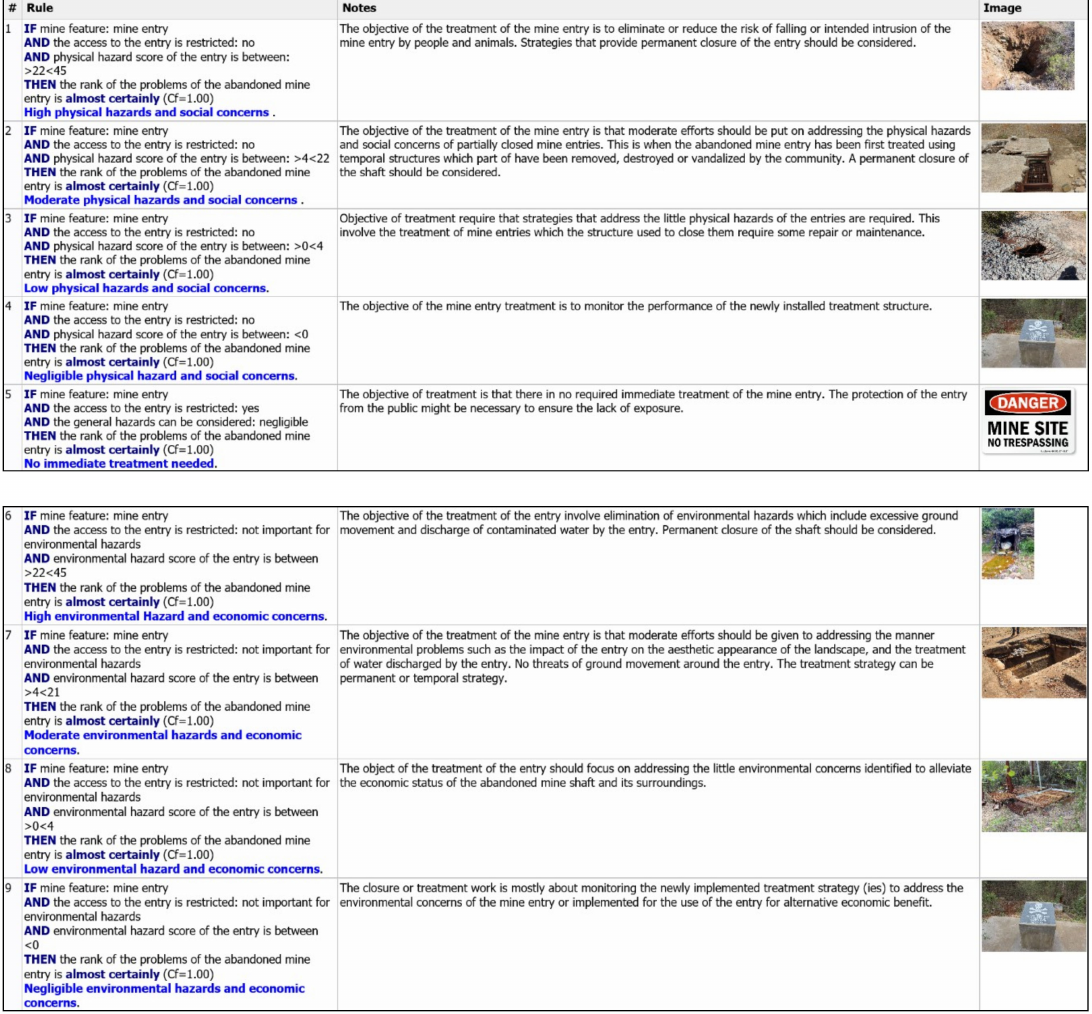
Figure A1. The knowledge base rules of the